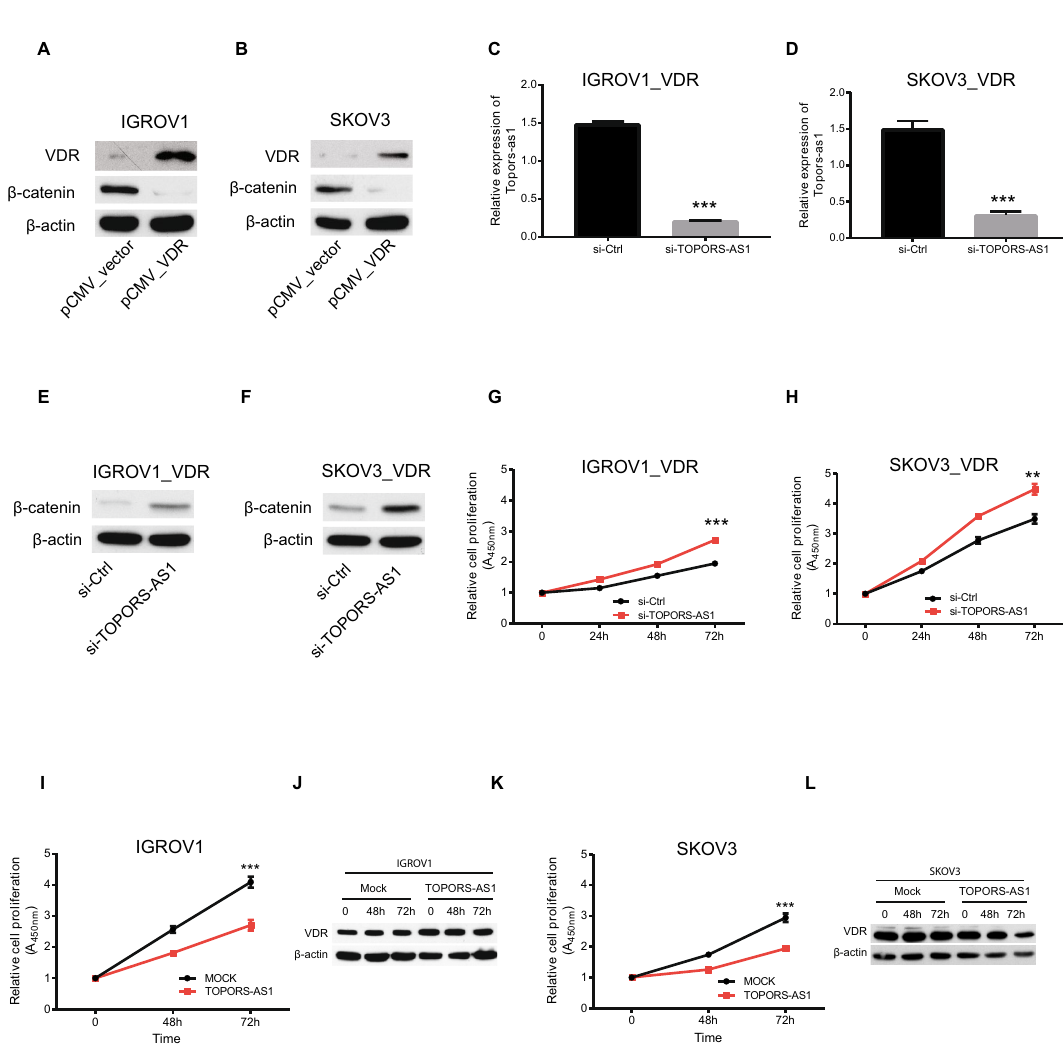
Figure 5. TOPORS-AS1 mediates the effect of VDR on ovarian cancer cells . ( A , B ) Western blot results showing reduced β-catenin in IGROV1 and SKOV3 after VDR transfection. ( C , D ) RT-qPCR results showing TOPORS-AS1 knockdown by si-TOPORS-AS1 in VDR -transfected IGROV1 and SKOV3. ( E , F ) Western blot results showing increased β-catenin after TOPORS-AS1 knockdown by si-TOPORS-AS1 in VDR -transfected IGROV1 and SKOV3. ( G , H ) Increased cell proliferation in VDR -transfected IGROV1 and SKOV3 after TOPORS-AS1 knockdown by si-TOPORS-AS1. ( I , K ) Decreased cell proliferation in IGROV1 and SKOV3 after transfection with TOPORS-AS1. ( J , L ) Western blot results showing no change in VDR levels over time in IGROV1 and SKOV3 after transfection with TOPORS-AS1 . ***P < 0.0001; **P <